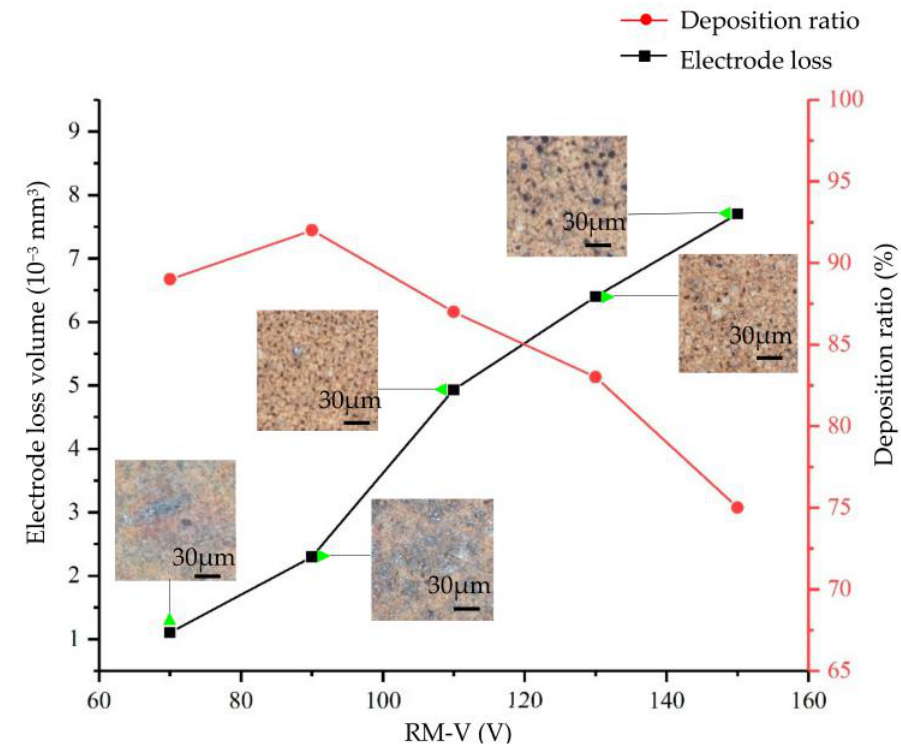
Figure 11. The e ff ect of RM-V on electrode loss volume and deposition